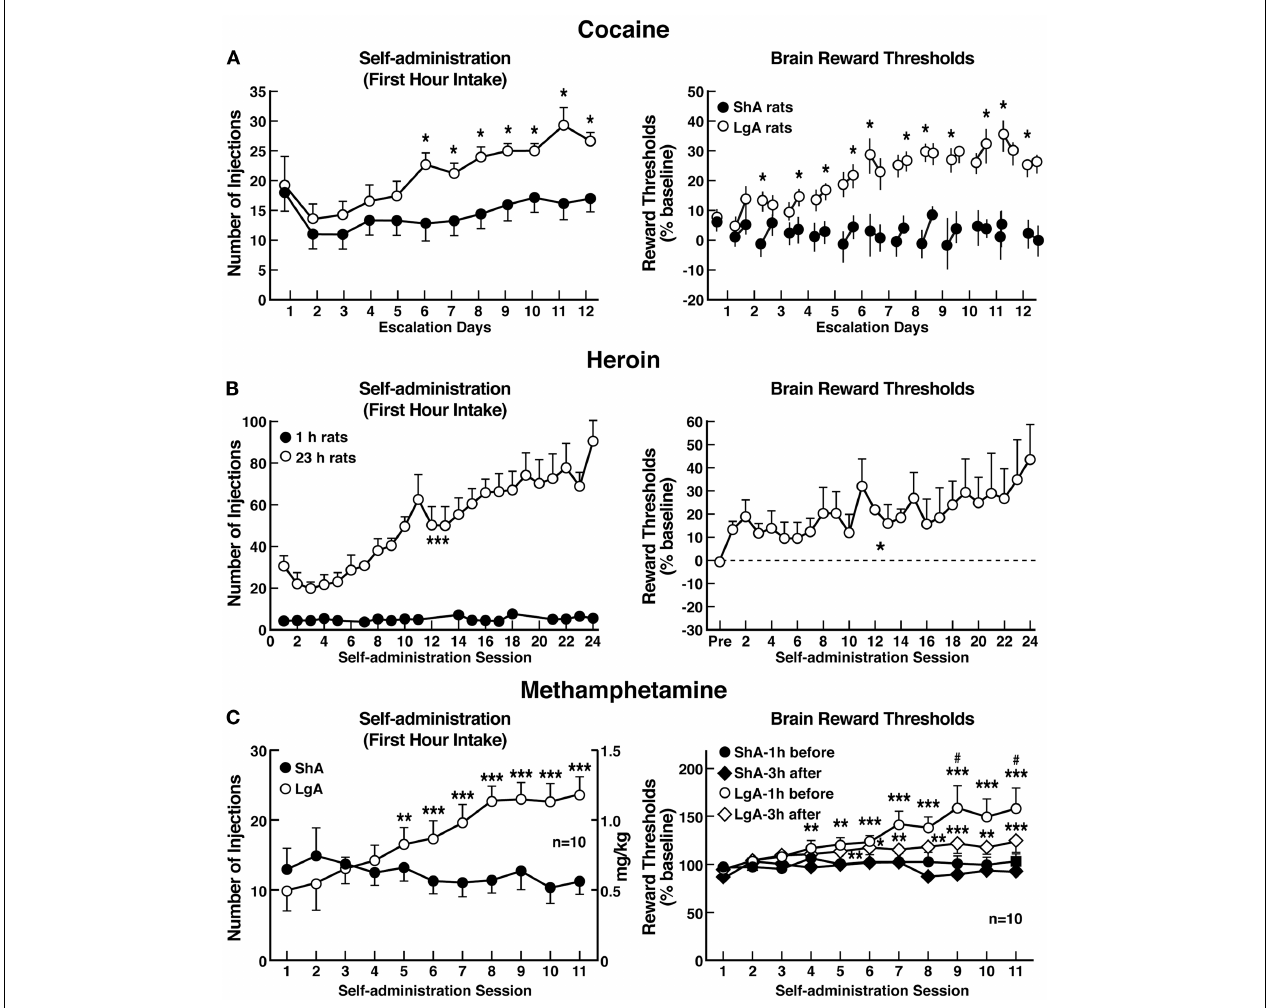
daily 23h self-administration session, became progressively more elevated as exposure to self-administered heroin increased